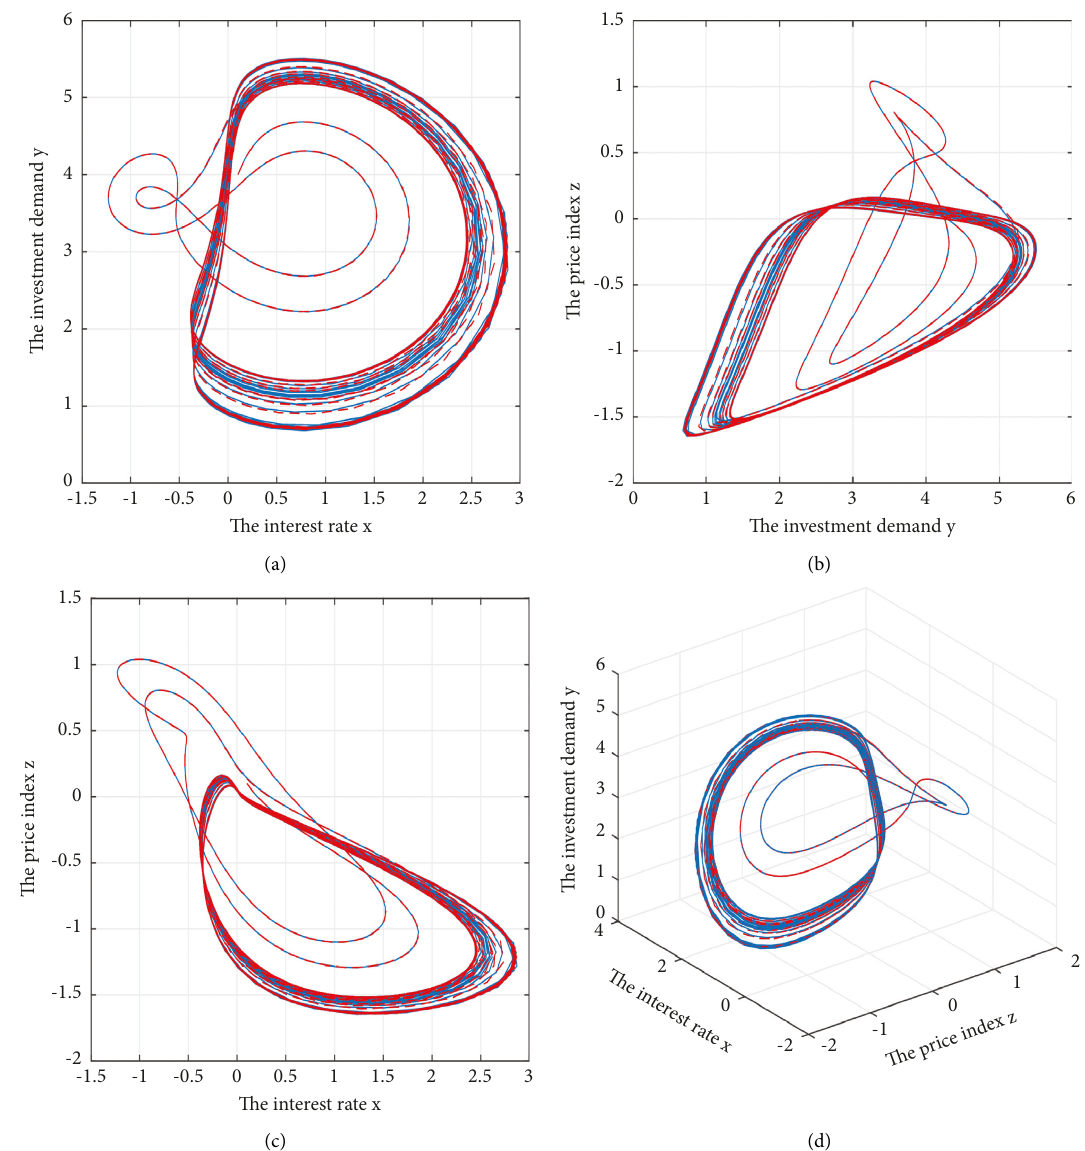
Figure 7: The phase portrait of the proposed model where (a) the demand of investment versus the rate of investment, (b) the index of price versus the demand of investment, (c) the index of price versus the rate of investment, and (d) the chaotic behaviour of the system with a � 3 . 0 ,b � 0 . 1 , c � 0 . 5 to identify the influence of these input parameters on the chaos of the